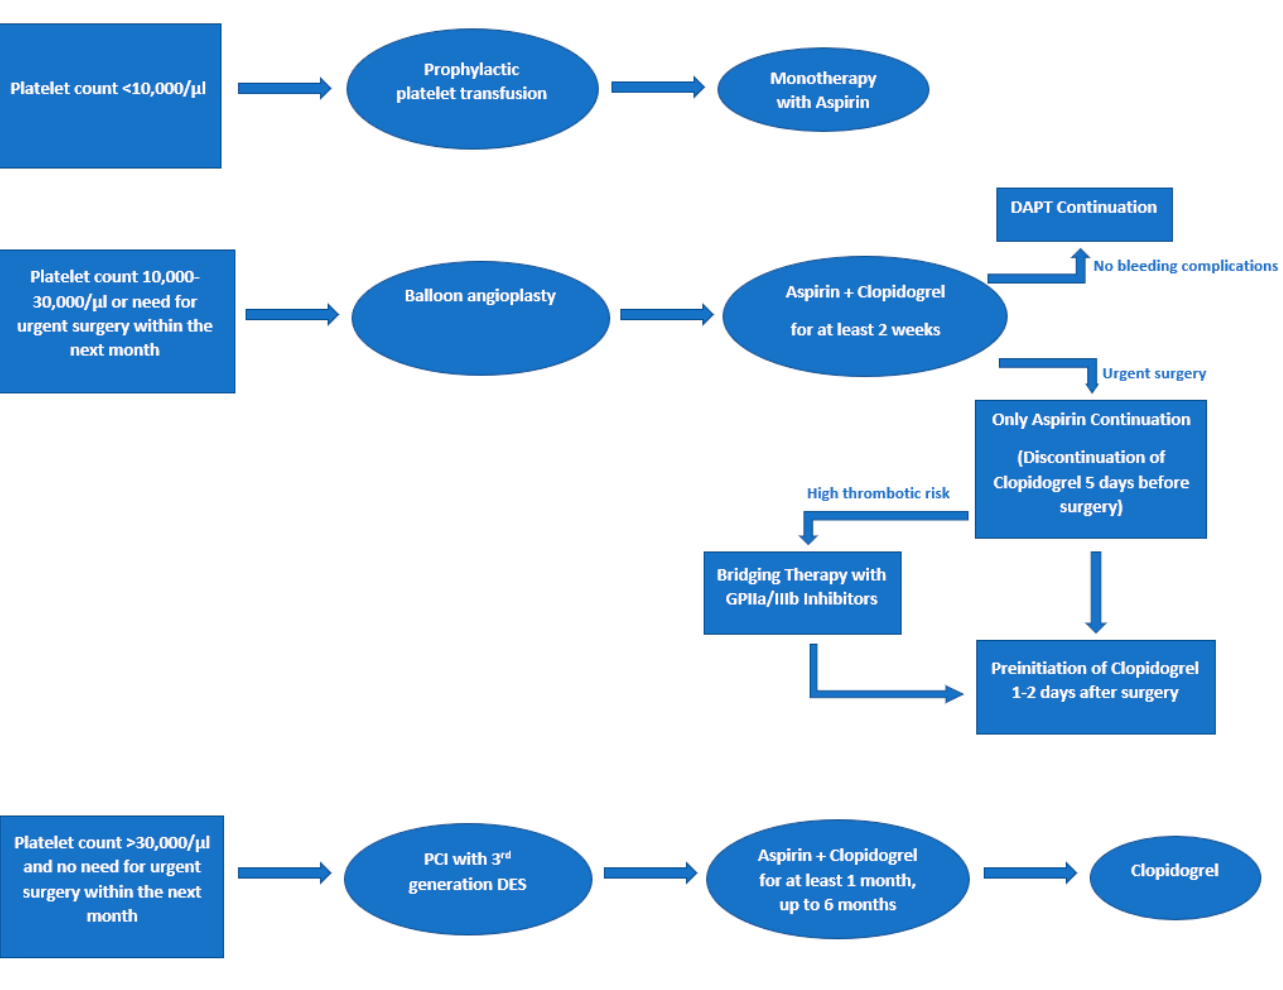
Figure 3. Modified algorithm of Radmilovic et al. for the management of antiplatelet therapy in cancer patients. DES = drug-eluting stent, DAPT = dual antiplatelet therapy, PCI = percutaneous coronary intervention.